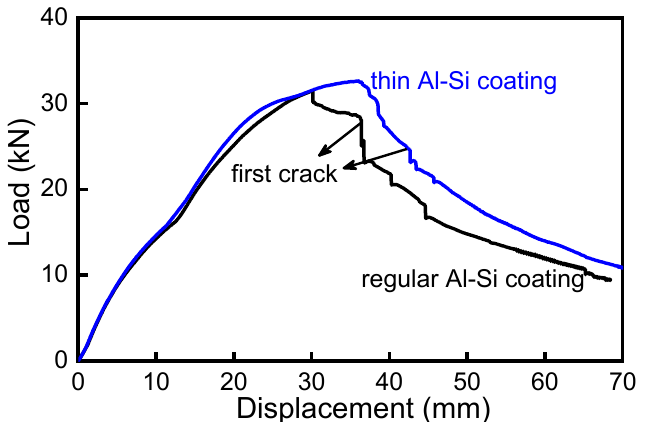
Figure 12. Performance comparison of press-hardened bumper beams in a static three-point bending test, with thin and regular Al–Si coatings [7].